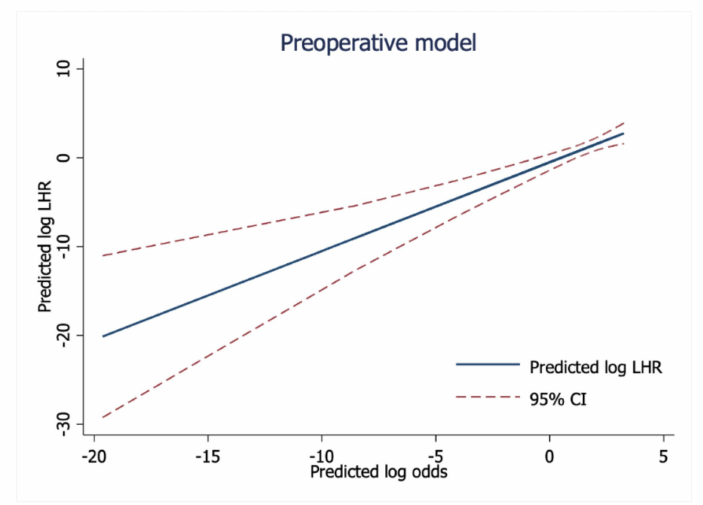
Figure A2. Predicted log-likelihood ratio (LHR) with 95% confidence interval of the preoperative model. Table A2. Predicted odds and likelihood ratio (LHR) in discriminating 1-year postoperative ambula- tory status at each decile from intraoperative model’s predictive odds.